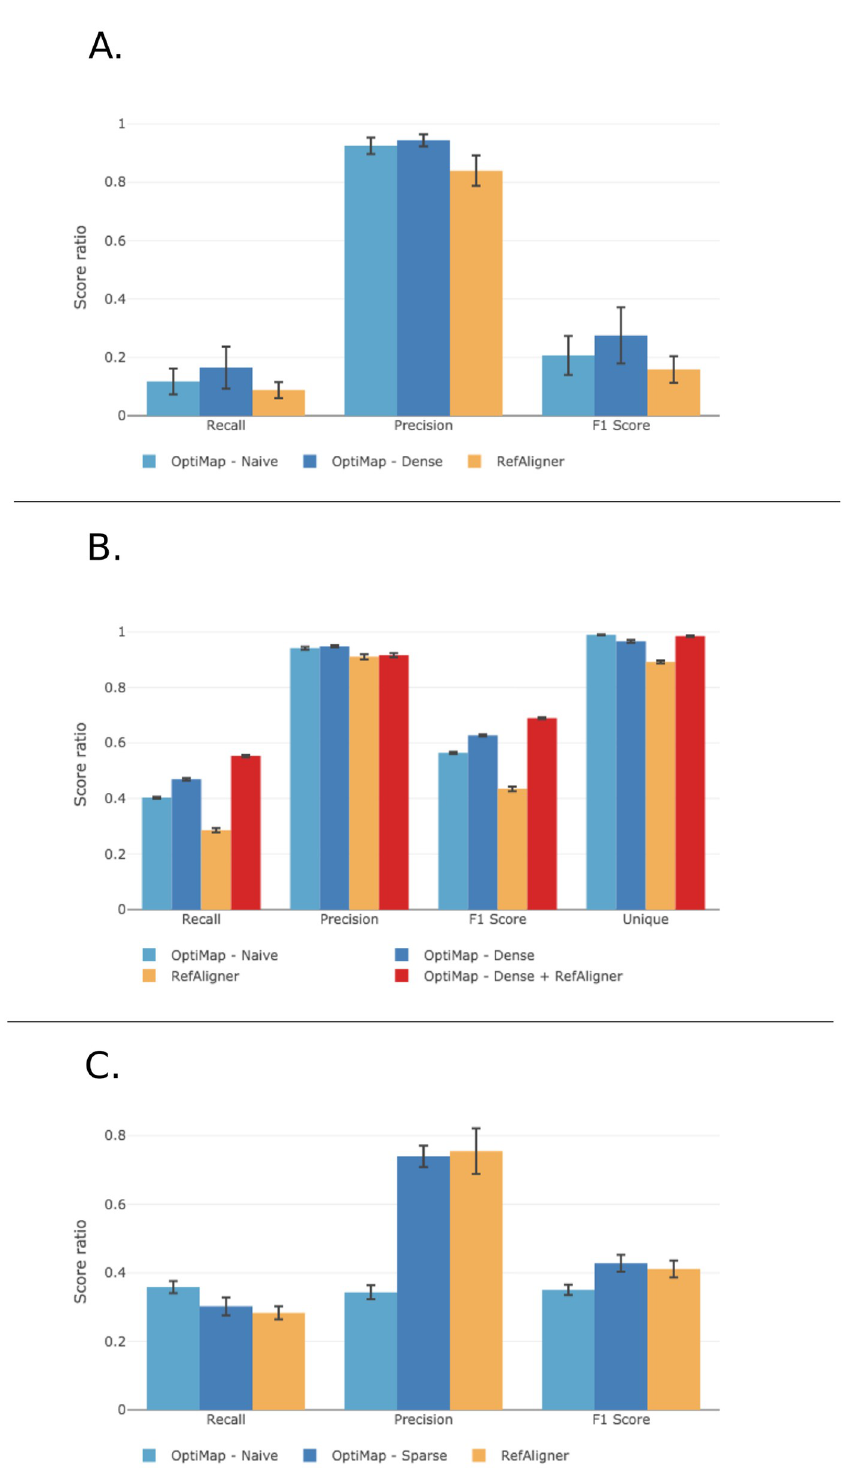
Fig 8. Alignment performance for yeast (A) and eggplant data (B,C). Precision, recall, unique molecules and F1 (harmonic mean) of alignments found for diferent molecule sets. A. Taken from all yeast contigs (avg. overlap rate 113x). B. Taken from the longest eggplant contigs ( > 5Mb, avg. overlap rate 17x). C. Eggplant molecules with a single overlap.